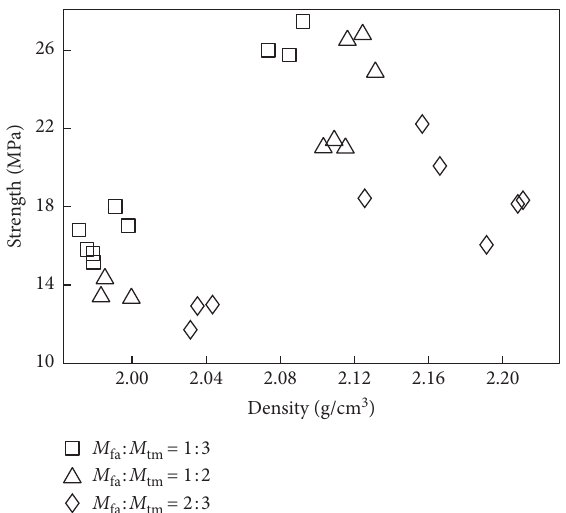
Figure 5: The density of geopolymer sample versus strength for different M